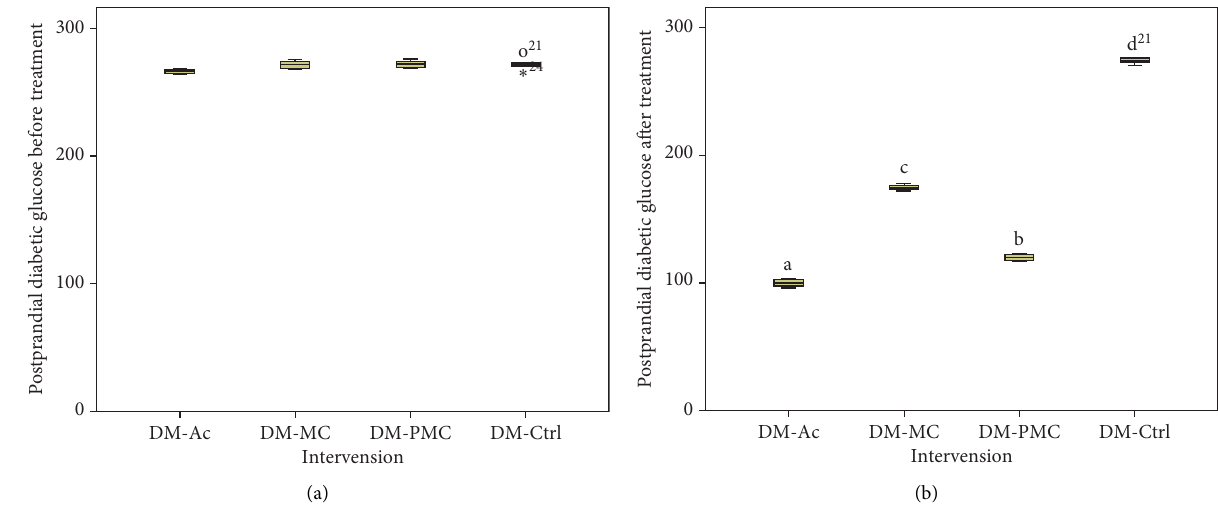
Figure 3: Postprandial diabetic glucose: (a) before treatment; (b) after treatment.